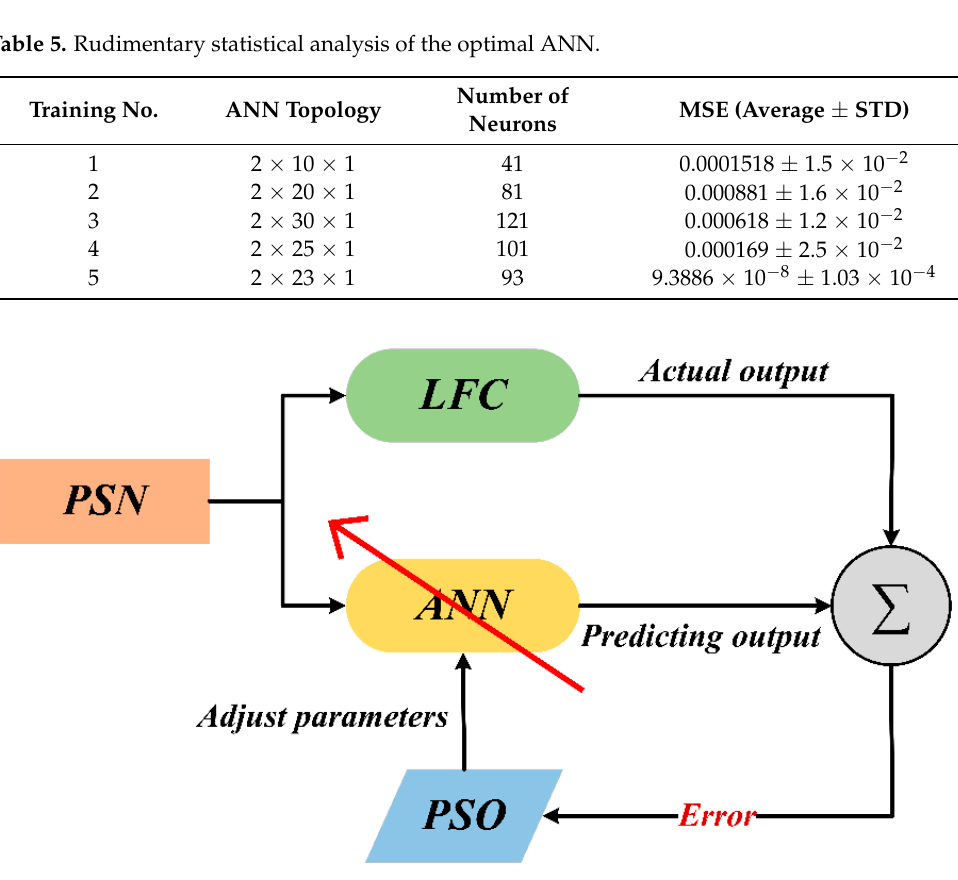
Figure 9. Schematic diagram of training ANN based on PSO.